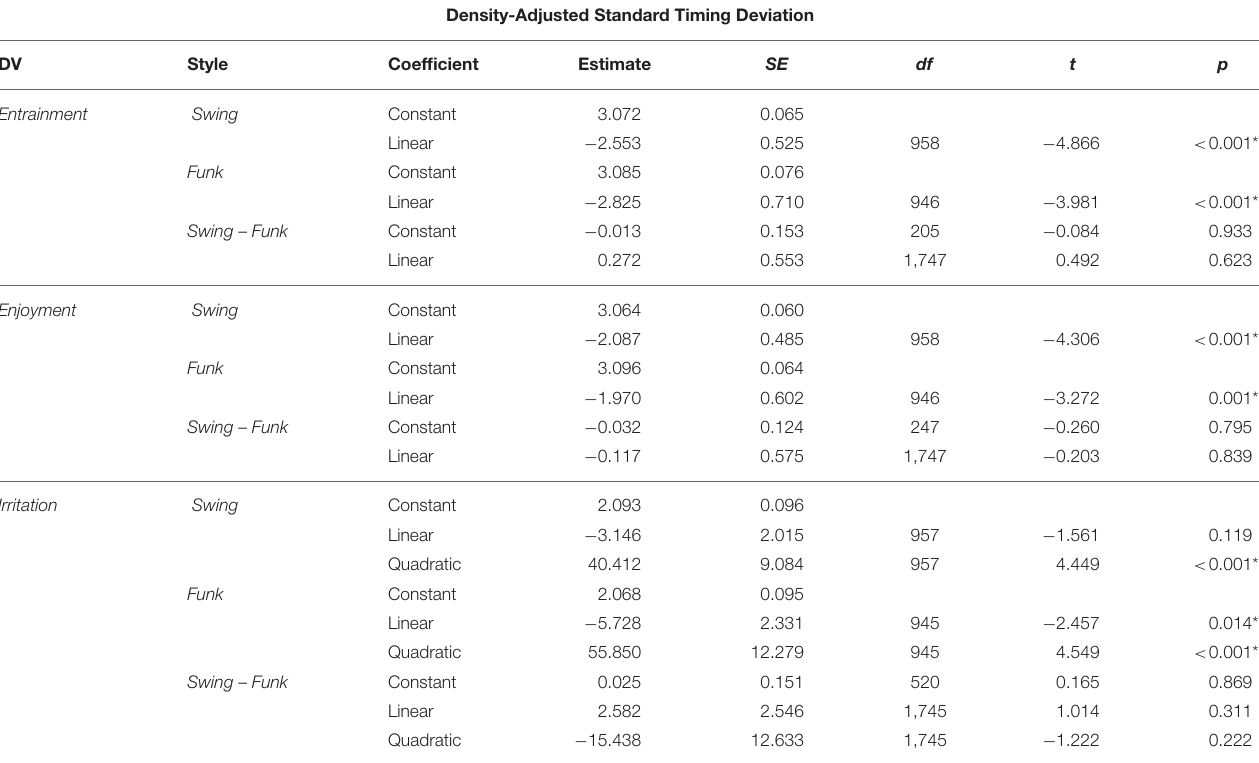
TABLE 4 | Regression models for the relationship between Density-Adjusted STD and Entrainment , Enjoyment , and Irritation for Swing , Funk , and the difference between Swing and Funk